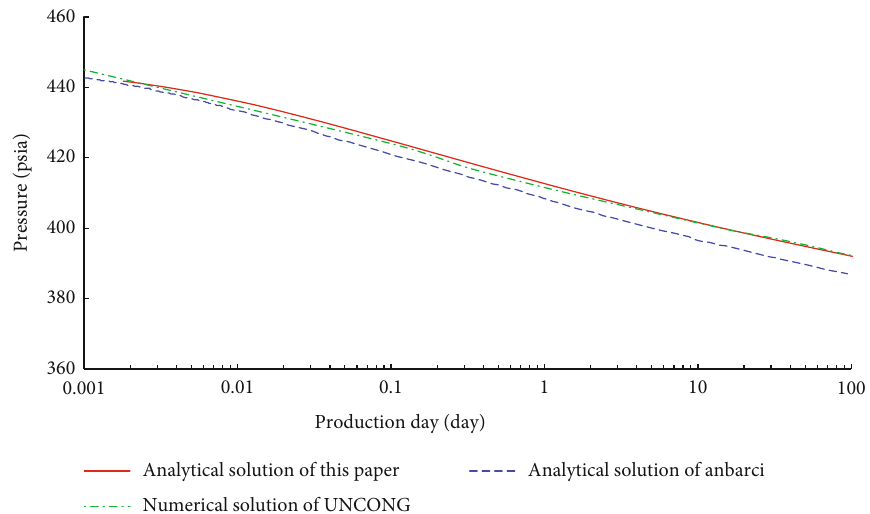
Figure 9: The comparison between classical literature and commercial numerical simulator.